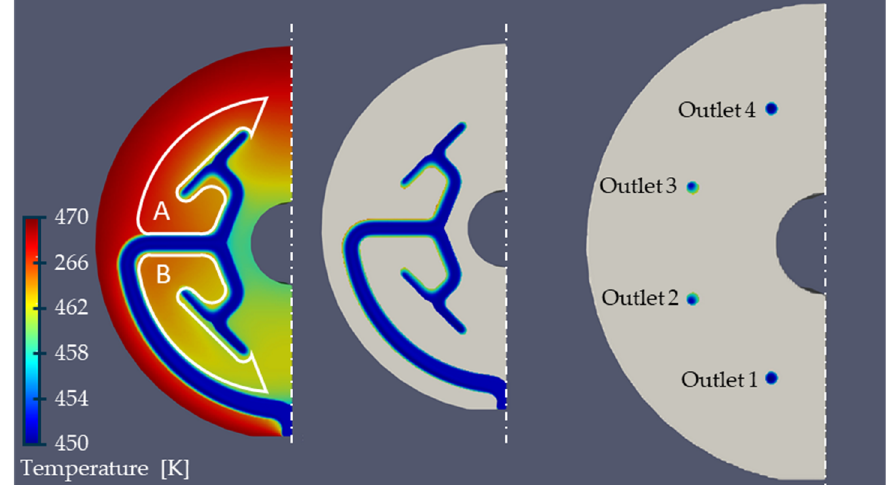
Figure 6. Temperature distribution in a 2 n -pre-distributor without heat pipes.